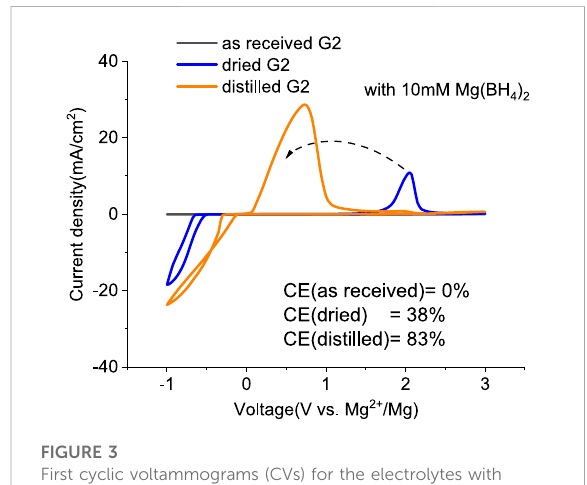
FIGURE 3 First cyclic voltammograms (CVs) for the electrolytes with 0.5 M MgTFIS 2 and 10 mM Mg (BH 4 ) 2 in G2 from as-received solvents,driedbymolecularsieves,anddistilled.Ptwasusedasthe working electrode, and the scan rate was 25 mV s − 1